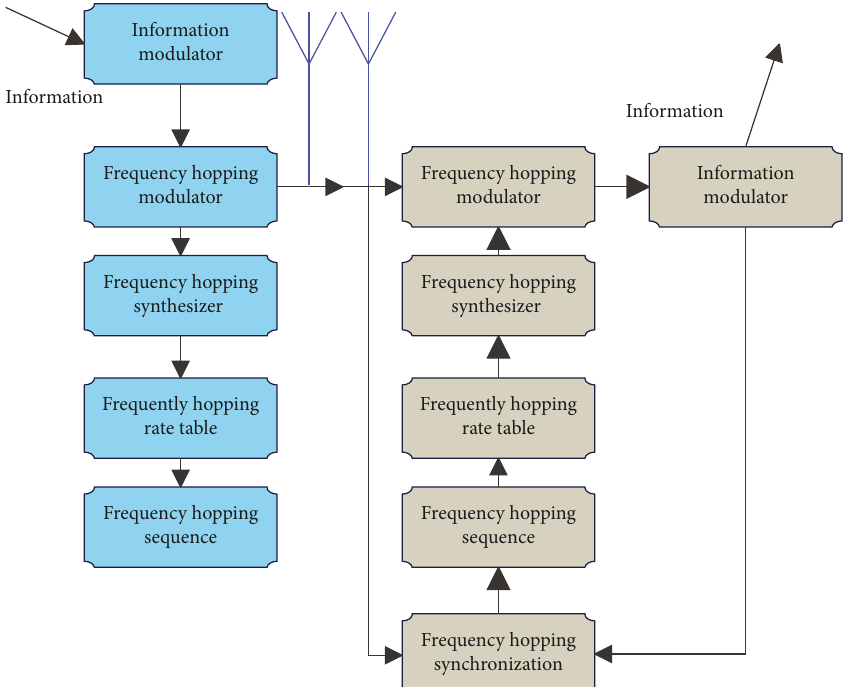
Figure 1: Block diagram of the working principle of the trombone timbre frequency communication